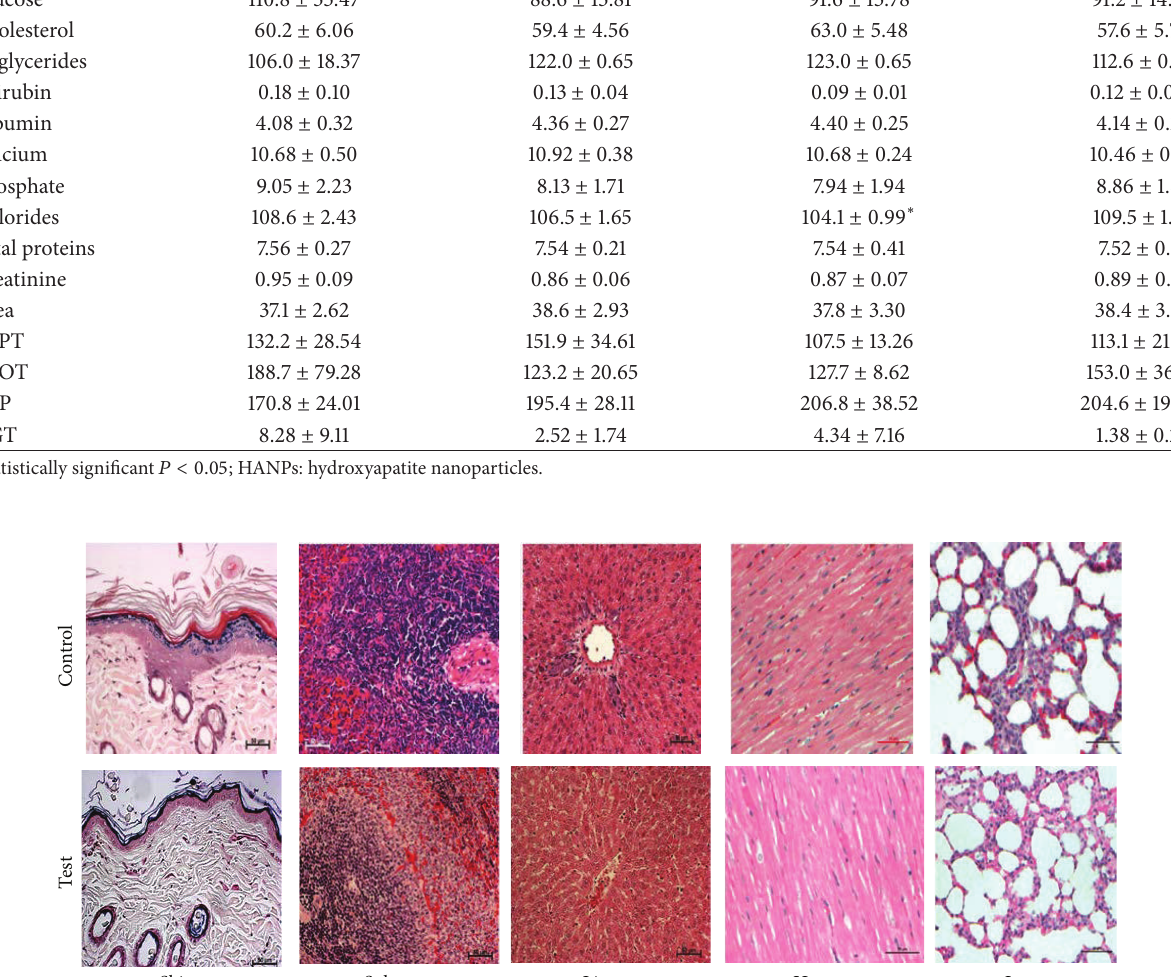
slightly reduced in 25 mg/kg ( 0.22 ± 0.02 units/mg pro- tein), 50 mg/kg ( 0.19 ± 0.0102 units/mg protein), and 100 mg/kg dose ( 0.19 ± 0.0102 units/mg protein)